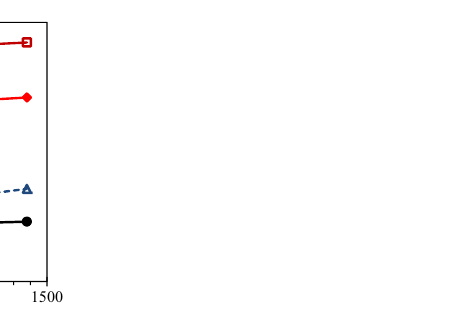
Figure 4. Effect of chemical treatment on Pb(II) adsorption [ C 0 = 50